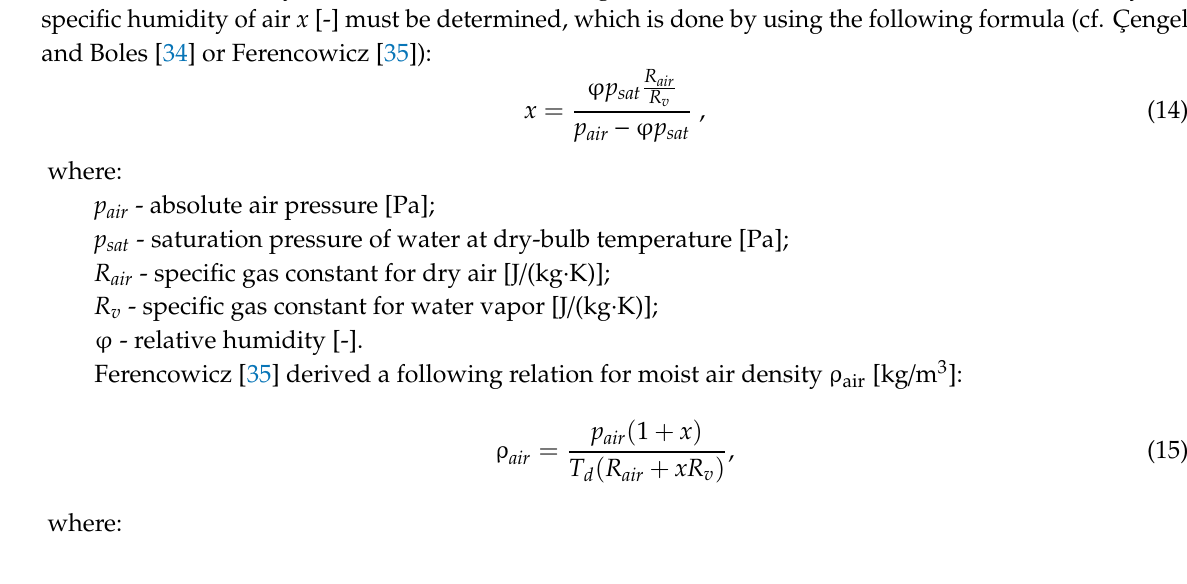
Figure 4. Applied system of apparatus: 1—a tube supplied air, 2—temperature equalizer, 3—nozzle, 4—electric heater, 5—thermcouple, 6—IAQ probe, 7—monitor with a creating